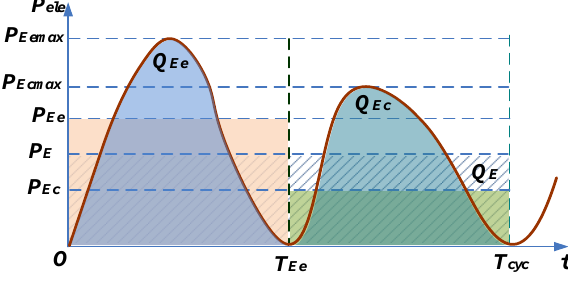
Figure 5. Electric power output of each operation cycle.